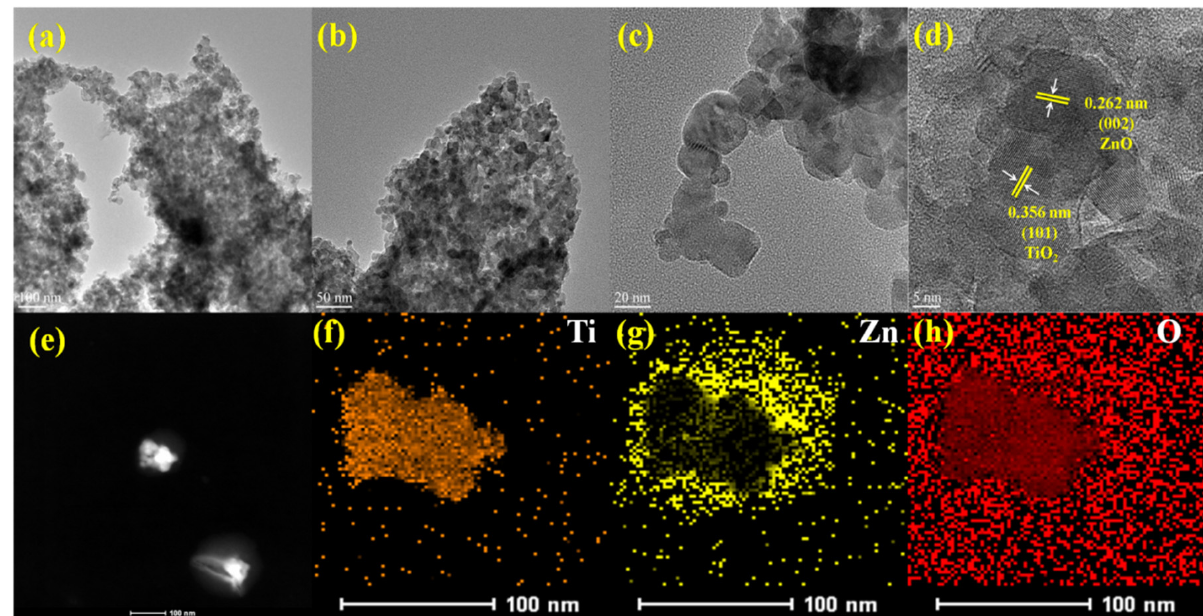
Figure 3. ( a , b ) TEM, ( c , d ) HRTEM and ( e ) STEM images and the corresponding ( f – h ) elemental mapping of the TZU75 nanocomposite.